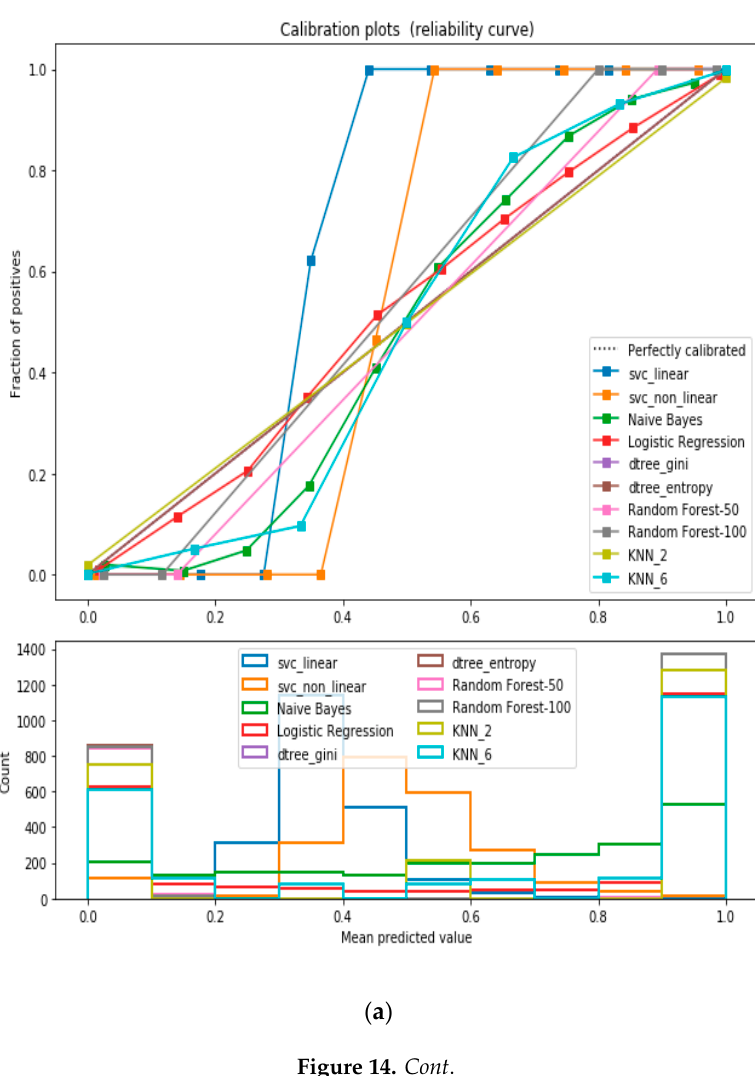
Figure 13. Performance metric of the “Decision Tree” classification with a 5-fold cross validation.